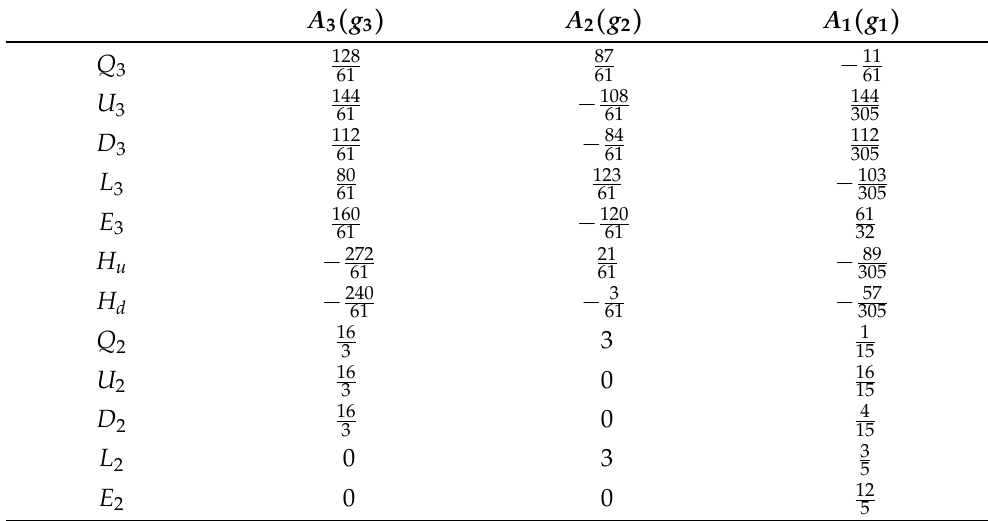
Table A1. The gauge field coefficients A i ( i = 1,2,3 ) within the wavefunction for MSSM